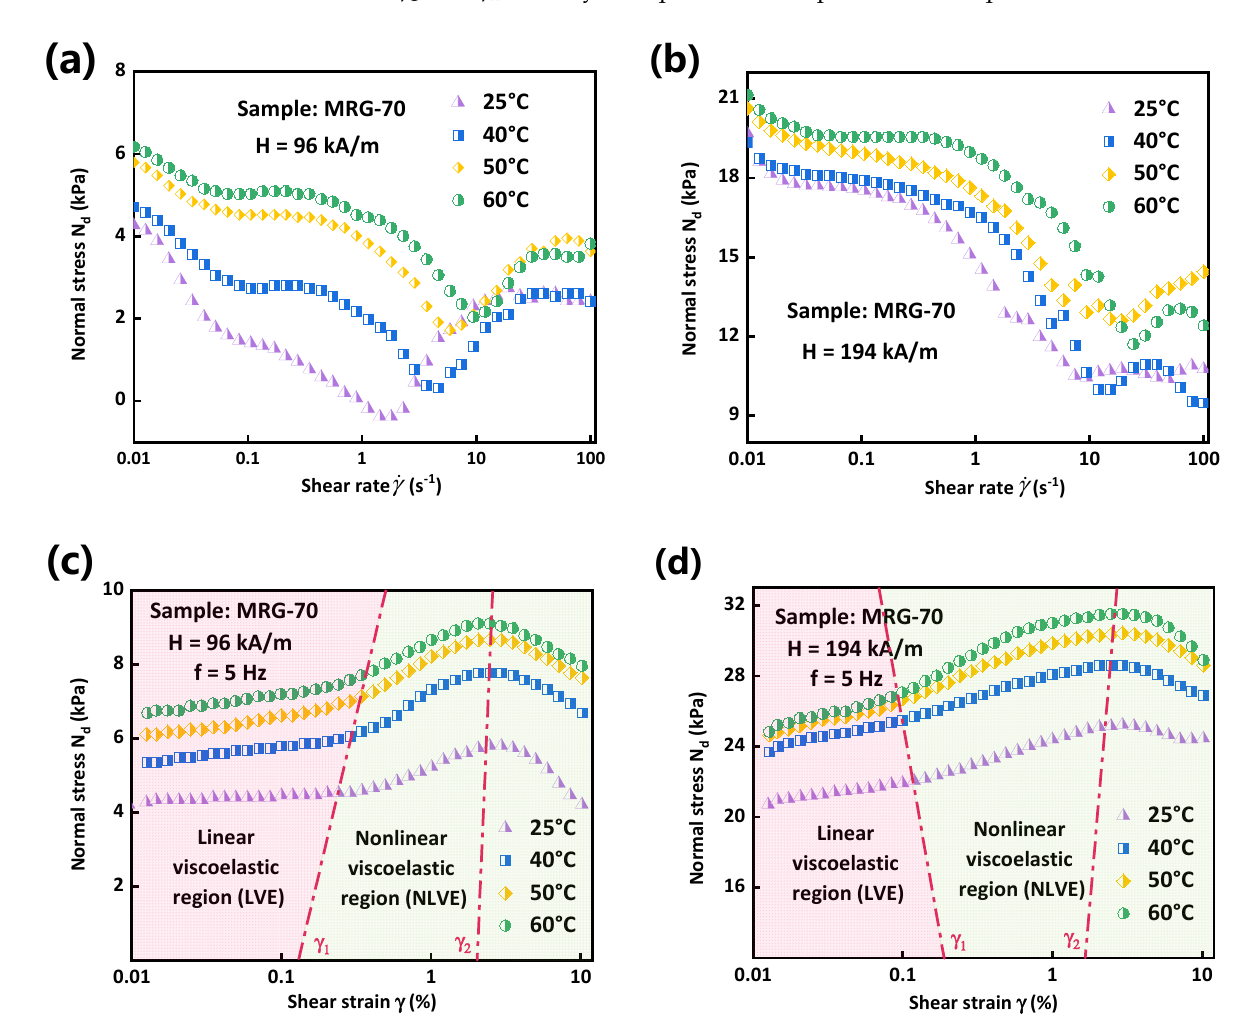
Figure 9. Normal stress of MRG as function of shear rate under 96 kA/m ( a ) and 194 kA/m ( b ), and shear strain under 96 kA/m ( c ) and 194 kA/m ( d ).